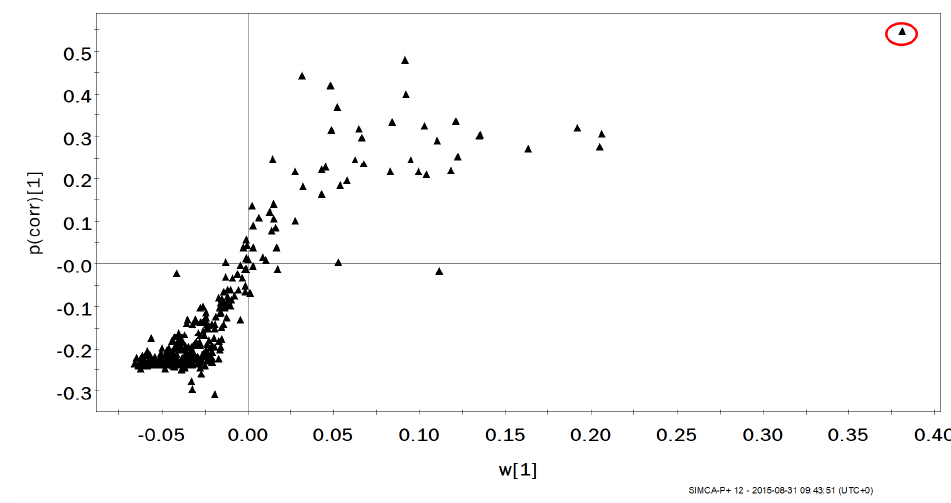
Figure 1. S-plot for modelled variables using an orthogonal partial least squares-discriminant analysis model for pre-exercise and post-exercise breath samples. A candidate biomarker is highlighted in the red oval.